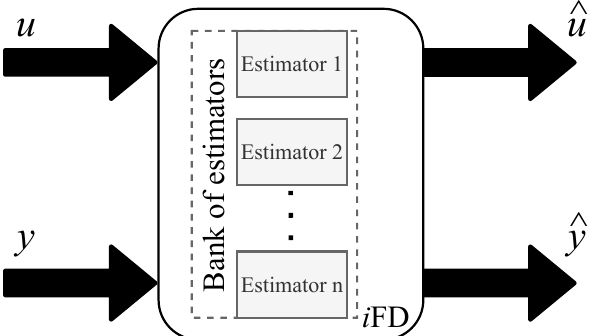
Figure 1. Bank of estimators (dotted lines) vs. proposed i FD (bold lines) for actuators/sensors